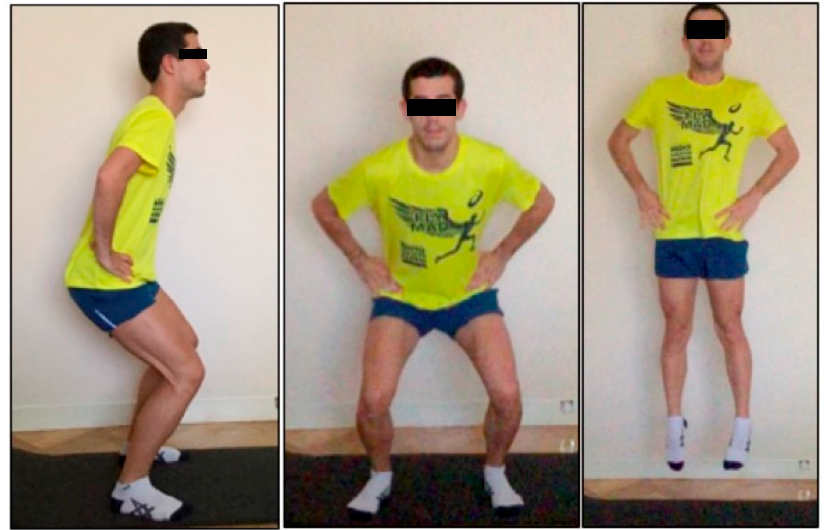
Figure 2. Squat jump position and execution.